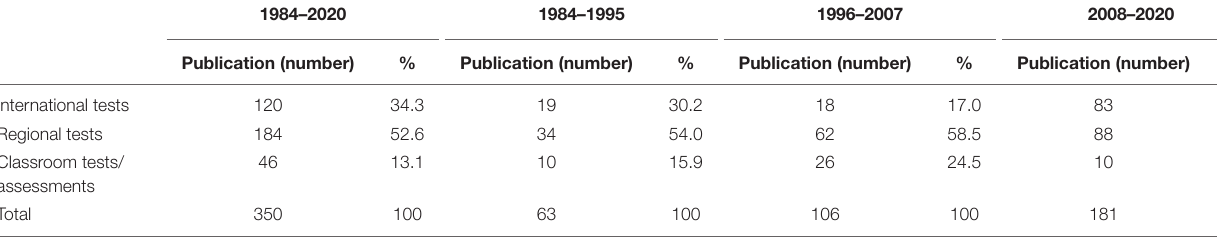
TABLE 2 | Most frequently researched test types.